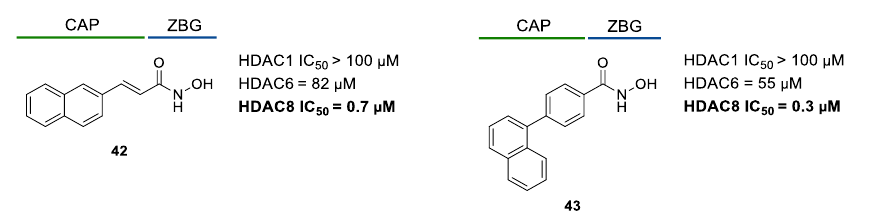
Figure 7. Structures and IC 50 of 42 and 43 [150].